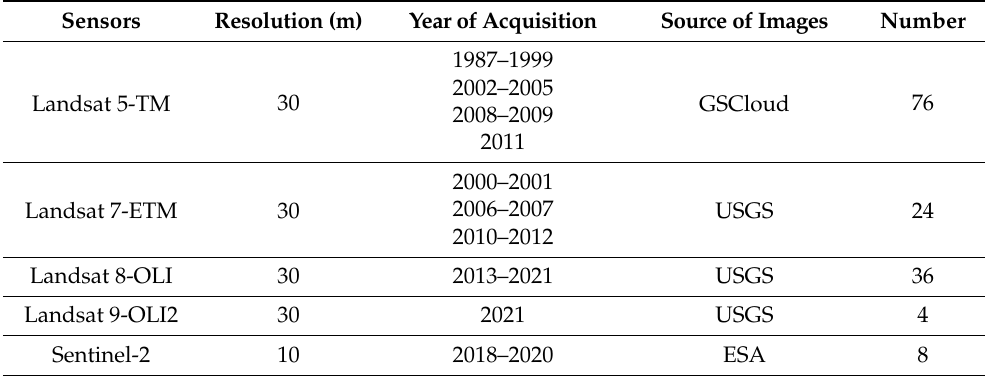
Table 1. Summary of specific information on multi-source remote sensing images.